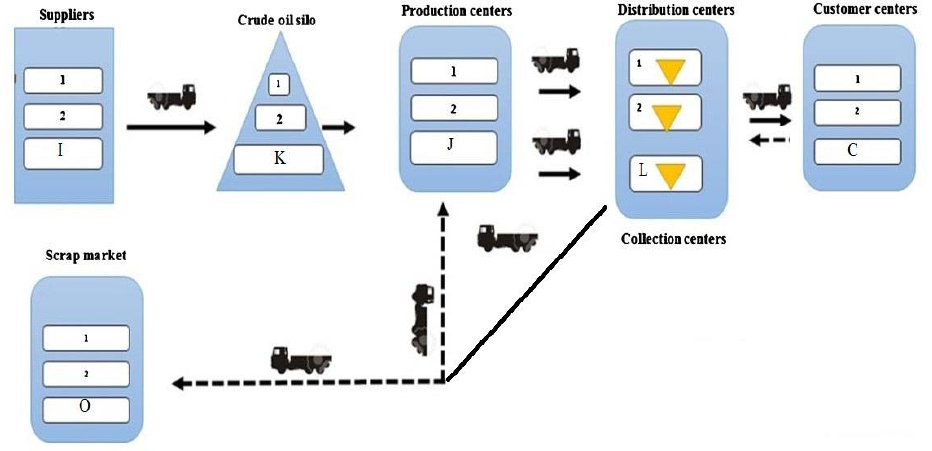
Figure 1. CLSC network framework.